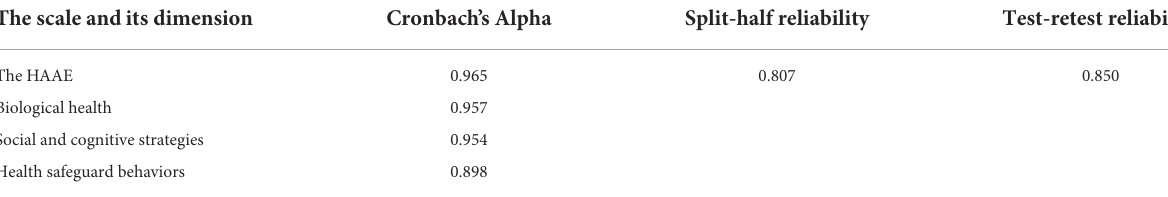
TABLE 2 Reliability analysis for Chinese version of the HAAE.